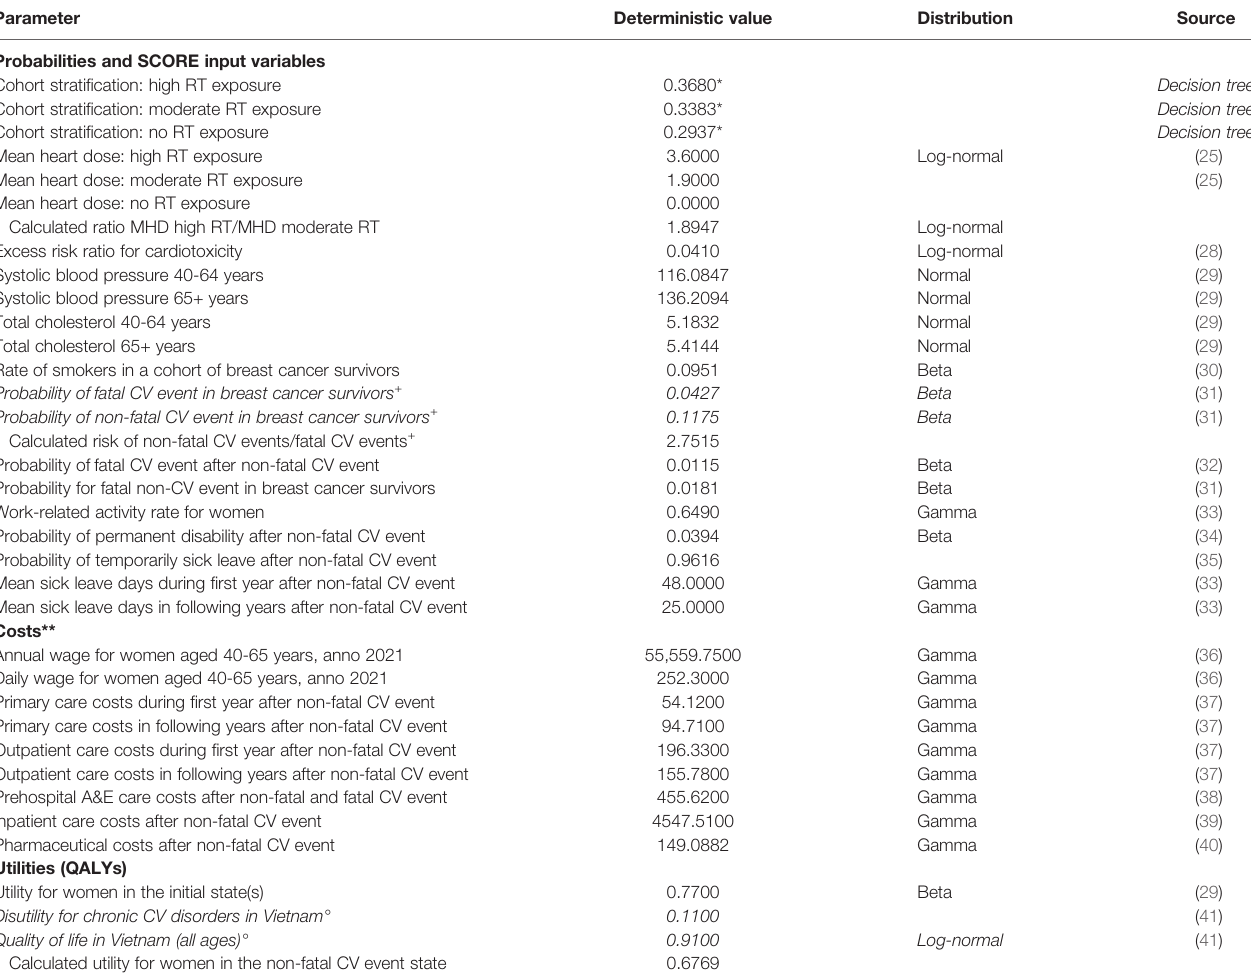
TABLE 1 | Model input parameters (probabilities, costs and